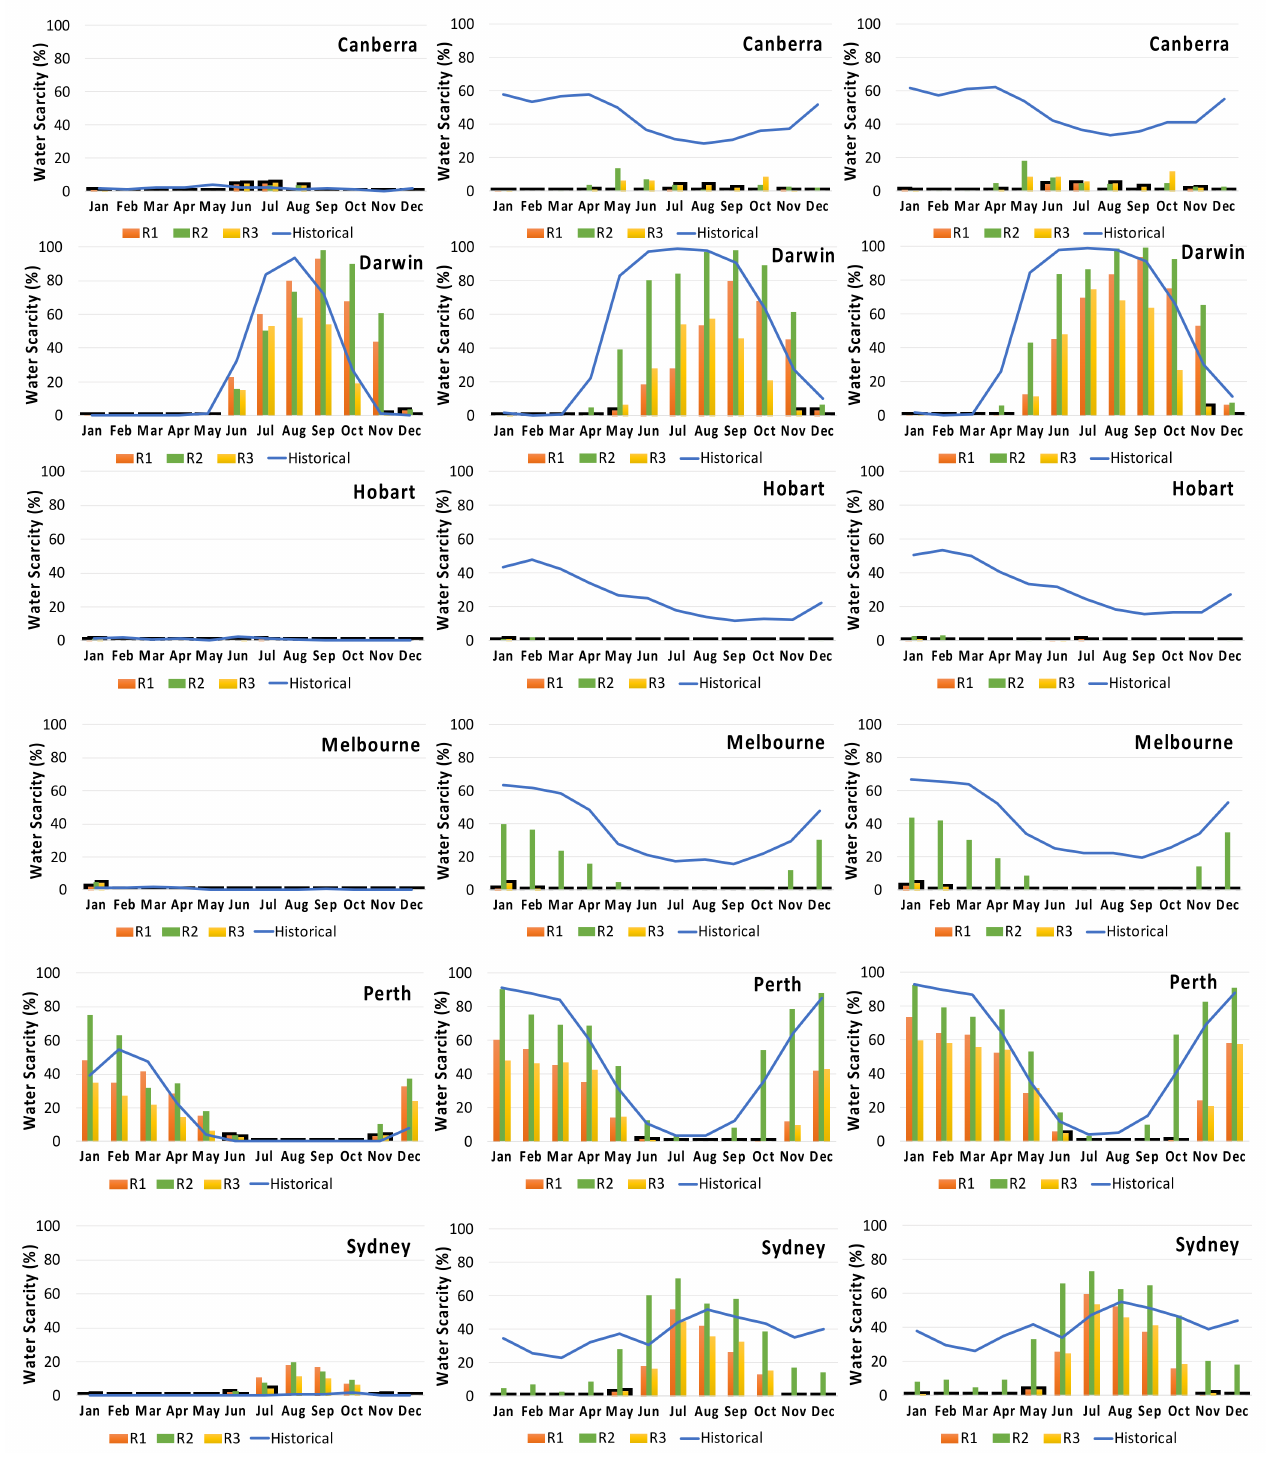
Figure 14. Water scarcity for all eight selected locations for both the historical and future period for TLD, irrigation and combined